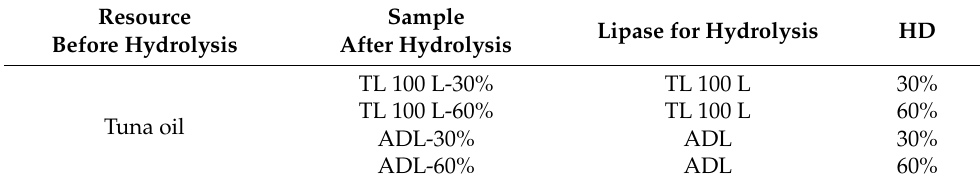
Table 1. Description of the four